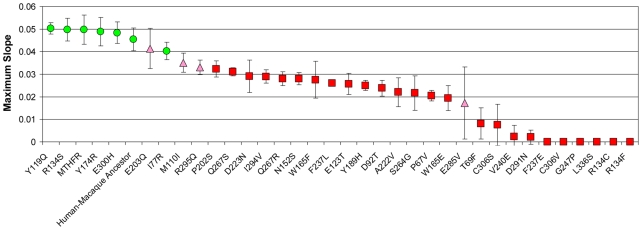
Activities of MTHR mutants.The average maximum slope (growth-rate metric) and standard deviation for each of the 36 MTHFR variants tested as in Methods. Replicate sets (N = 5) were compared against a positive control (major MTHFR allele) and a negative control (A222V allele) using 2 different statistical criteria as described in Methods. Green circles indicate changes not significantly different from the positive control and significantly better than the A222V control and indicate functionality. Red squares indicate changes significantly less active than the positive control and not significantly better than the A222V control and indicate impaired alleles. Pink triangles are classified as equivocal due to disagreement in the statistical methods. The raw replicate data and statistical metrics are in Table S1.